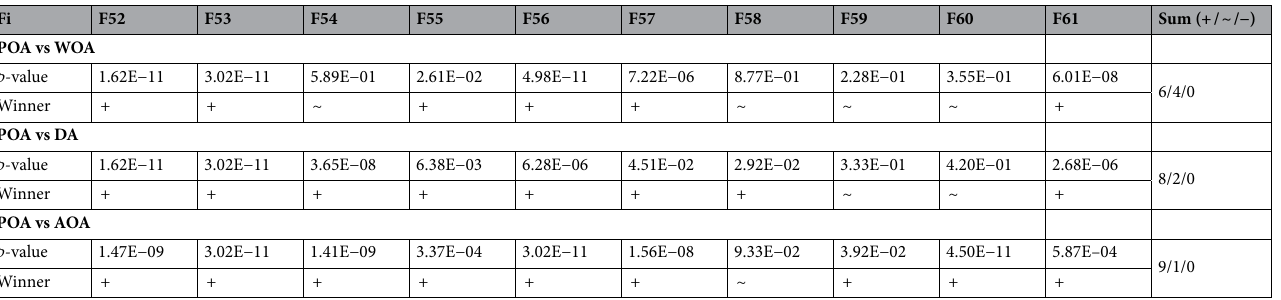
Table 12. Results of Wilcoxon sign-rank test for CEC 2019 problems with α =